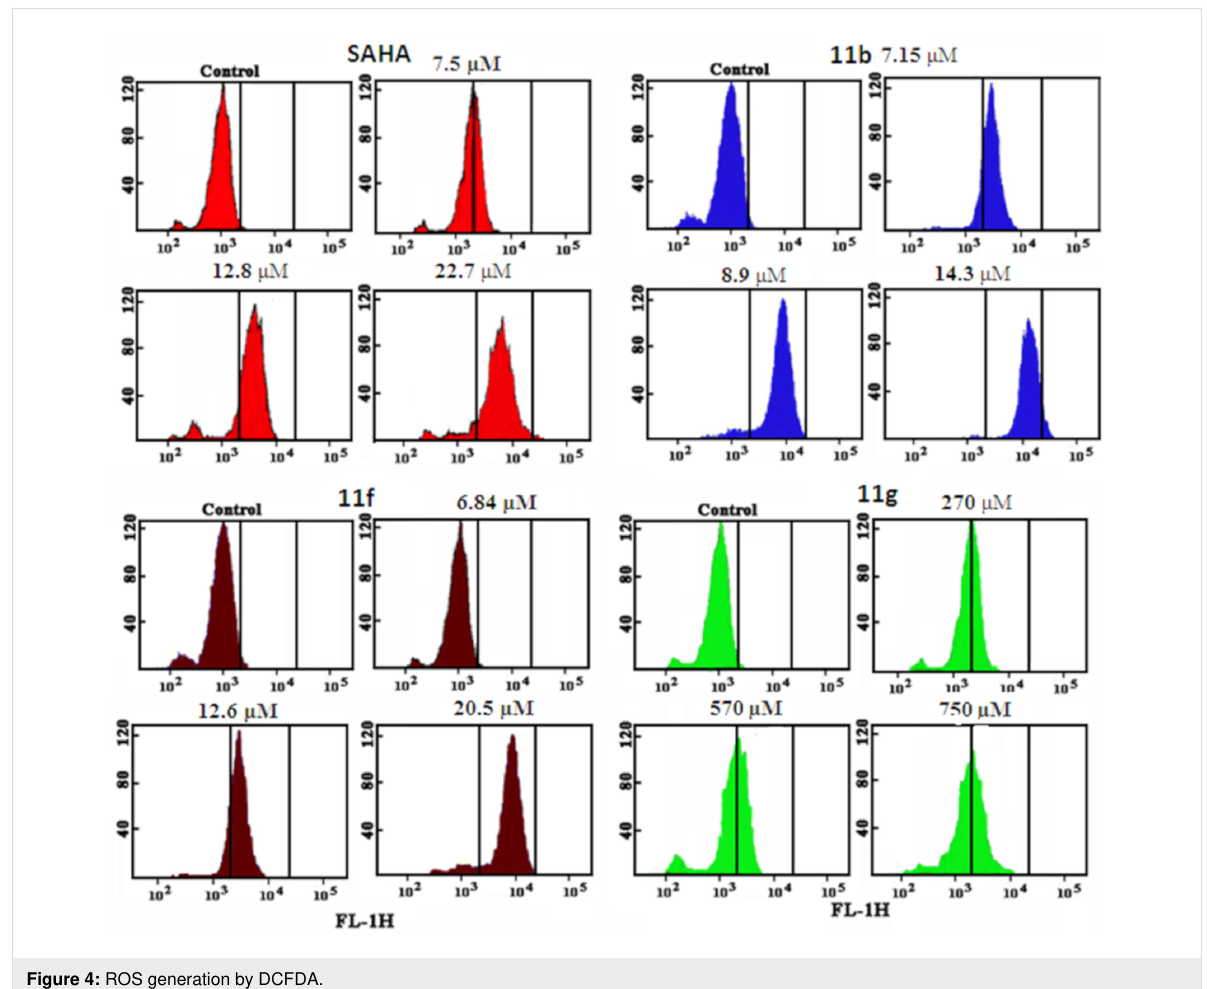
Figure 4: ROS generation by DCFDA.